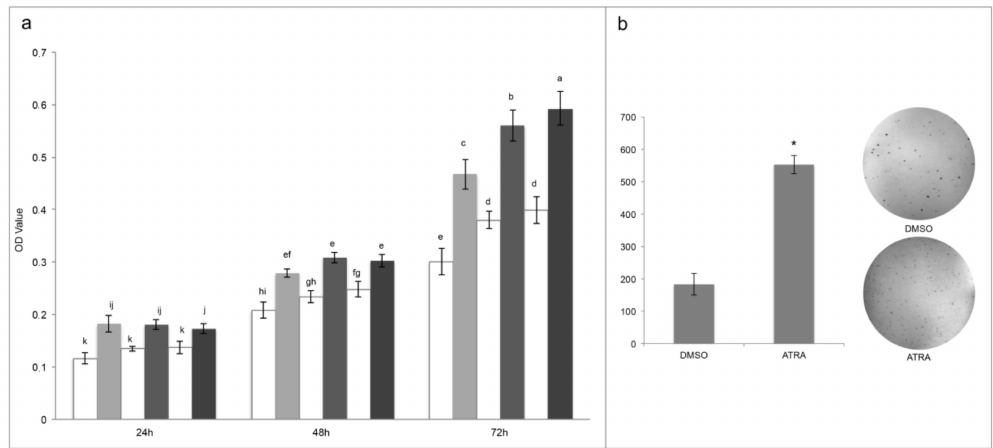
Figure 1. All-trans retinoic acid (ATRA) treatments induce T24 proliferation. ( a ) MTT assays express as optical density (OD) values in T24 cells treated with di ff erent consecutive concentration of ATRA (grey scale: 1 µ M, 10 µ M, and 20 µ M) or respective concentration of vehicle DMSO (white: 0.002%, 0.02%, and 0.4%) (for 3 days). Means ± SD ( n = 12). Means with di ff erent letters are significantly di ff erent ( p < 0.05). ( b ) Colony formation assay. Representative image (out of 3) of colonies formed in soft agar by T24 cells treated with vehicle (DMSO) or ATRA (10 µ M). Means ± SD ( n = 3), * indicates the statistically significant di ff